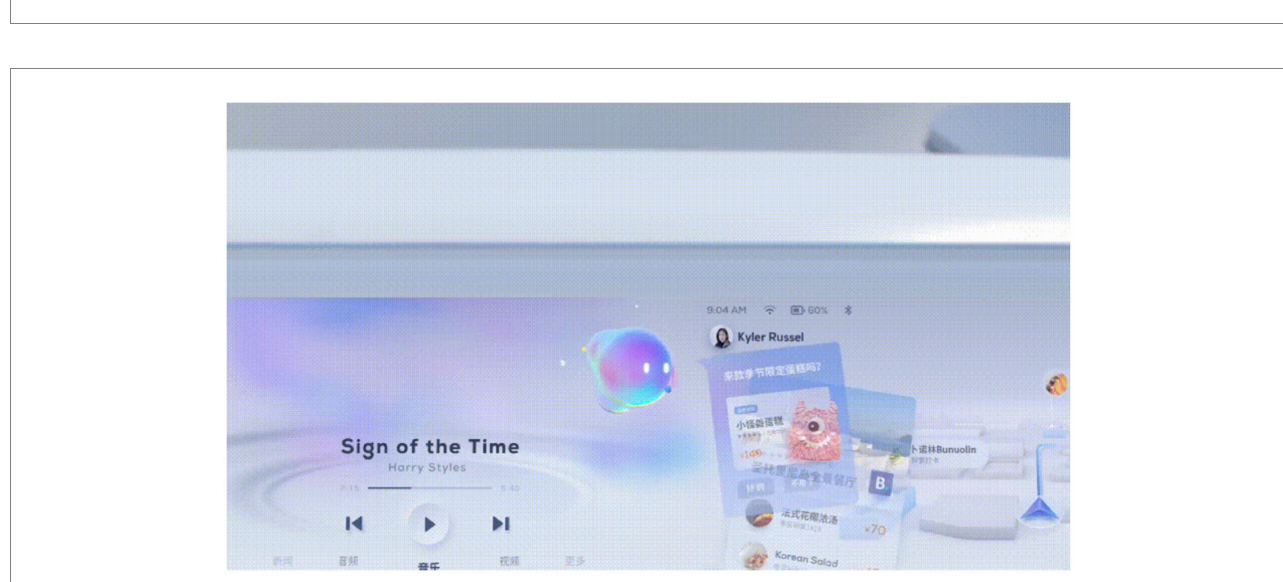
FIGURE 3 Video screenshot of the experimental material of the virtual